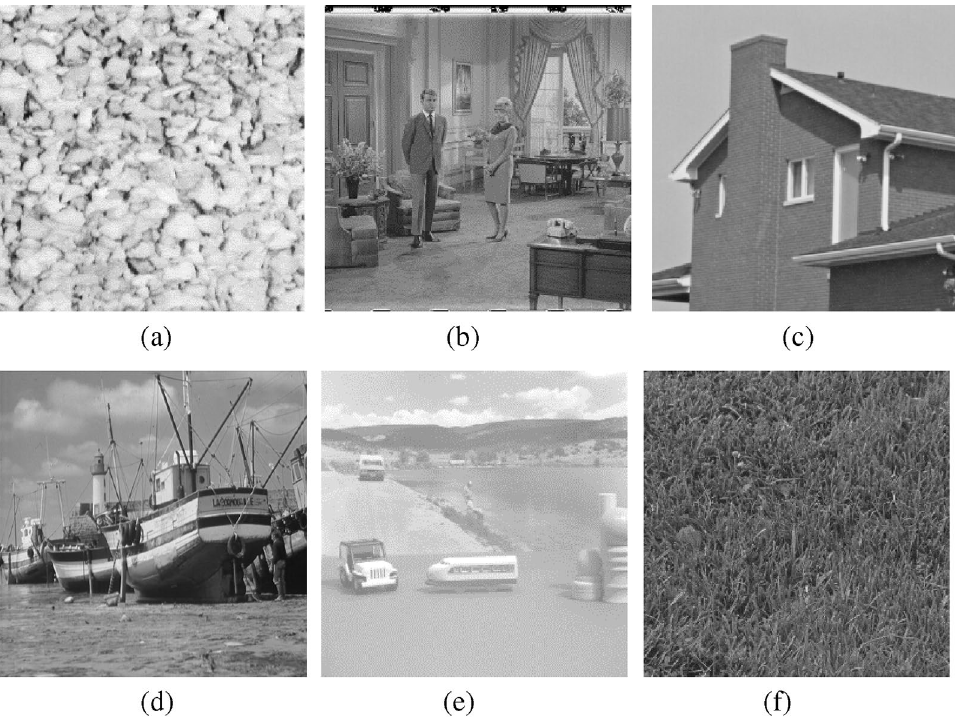
Figure 7. The example images. ( a ) Gravel ( b ) Couple ( c ) House ( d ) Boat ( e ) Toy Vehicle ( f ) Grass.